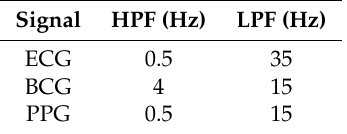
Table 1. The cutoff frequency of the filter applied to each